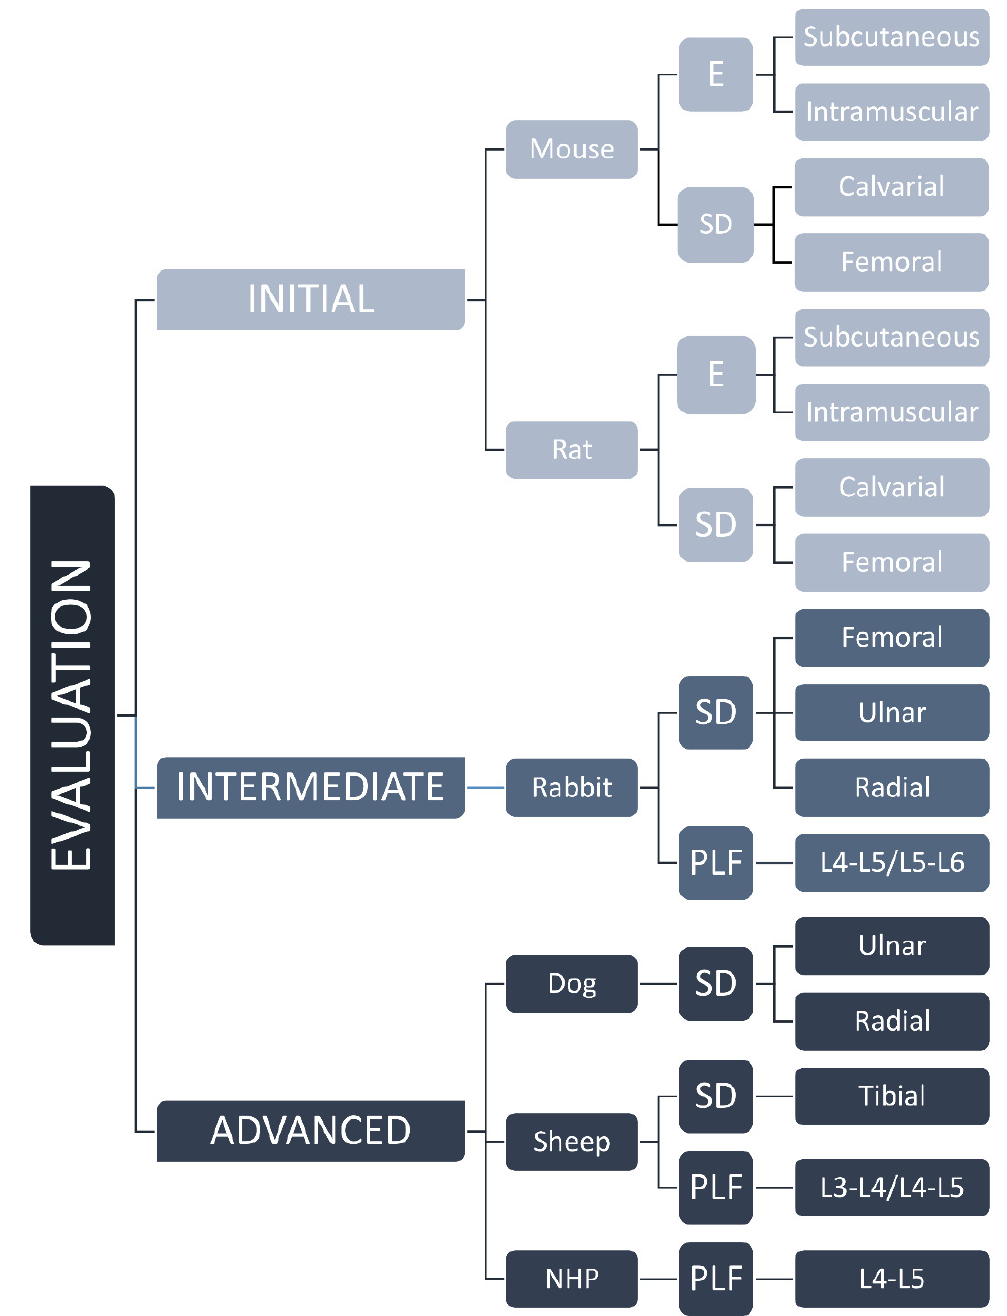
Figure 1. Classification of animal models from mouse to NHP based on the stage of preclinical development, namely as initial, intermediate, and advanced evaluation of osteoinductive devices. E—ectopic, SD—segmental defect, PLF— posterolateral spinal fusion models, and L—level of lumbar transverse